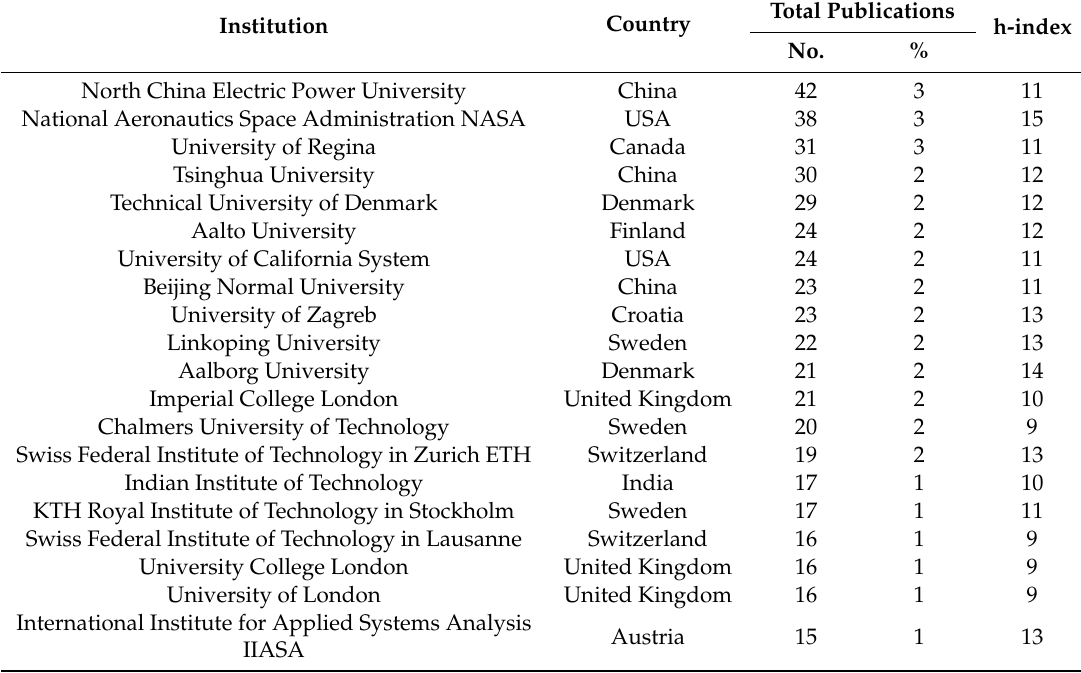
Table 4. The top 20 of the most productive institutions in terms of publications on municipal energy system planning. The percentage values refer to the total of 1235